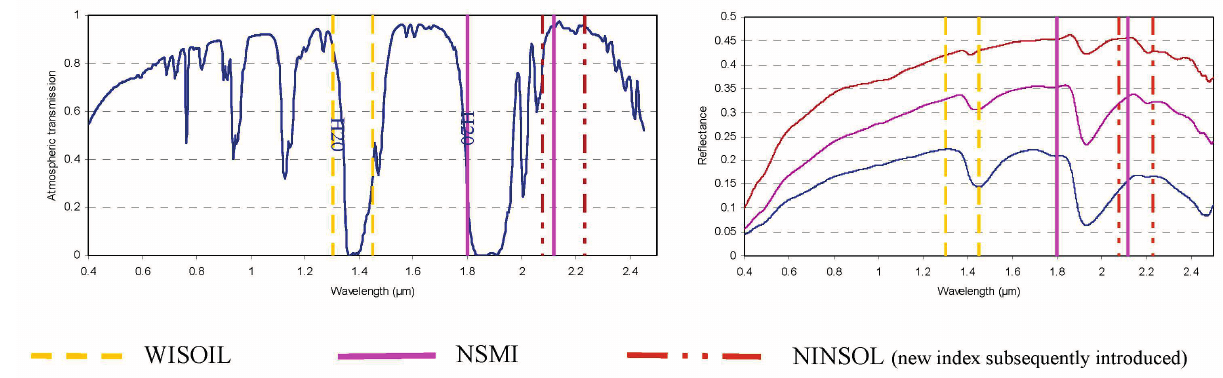
Figure 3. Location of the wavelengths operated by the spectral indices. These wavelengths are showed in the atmospheric transmission ( Left ) and the soil spectral signatures according to SMC ( Right ) graphs.